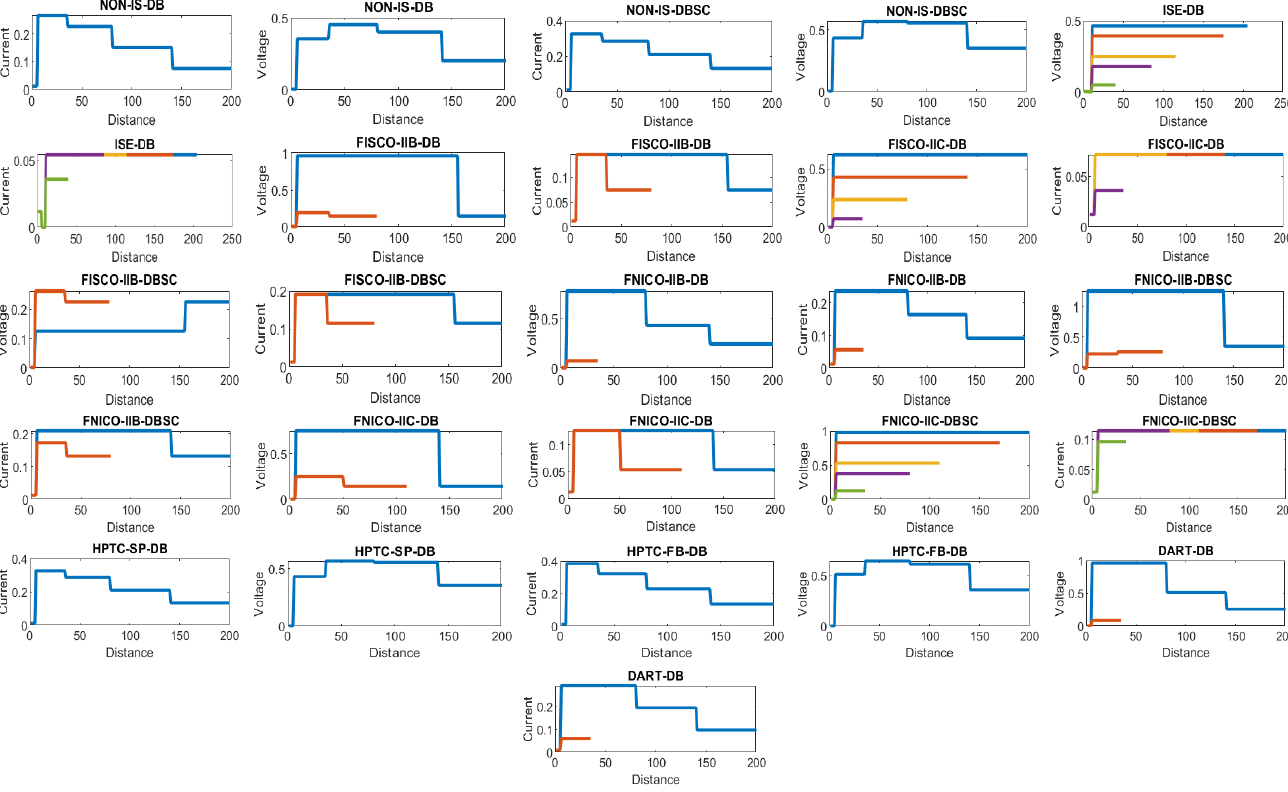
Figure 10. Illustration of voltage at farthest field devices, t otal segments’ lengths and percentage of them to the maximum allowable length of 1900 m and total number of segments for double bottom tanks ’ sub-models.